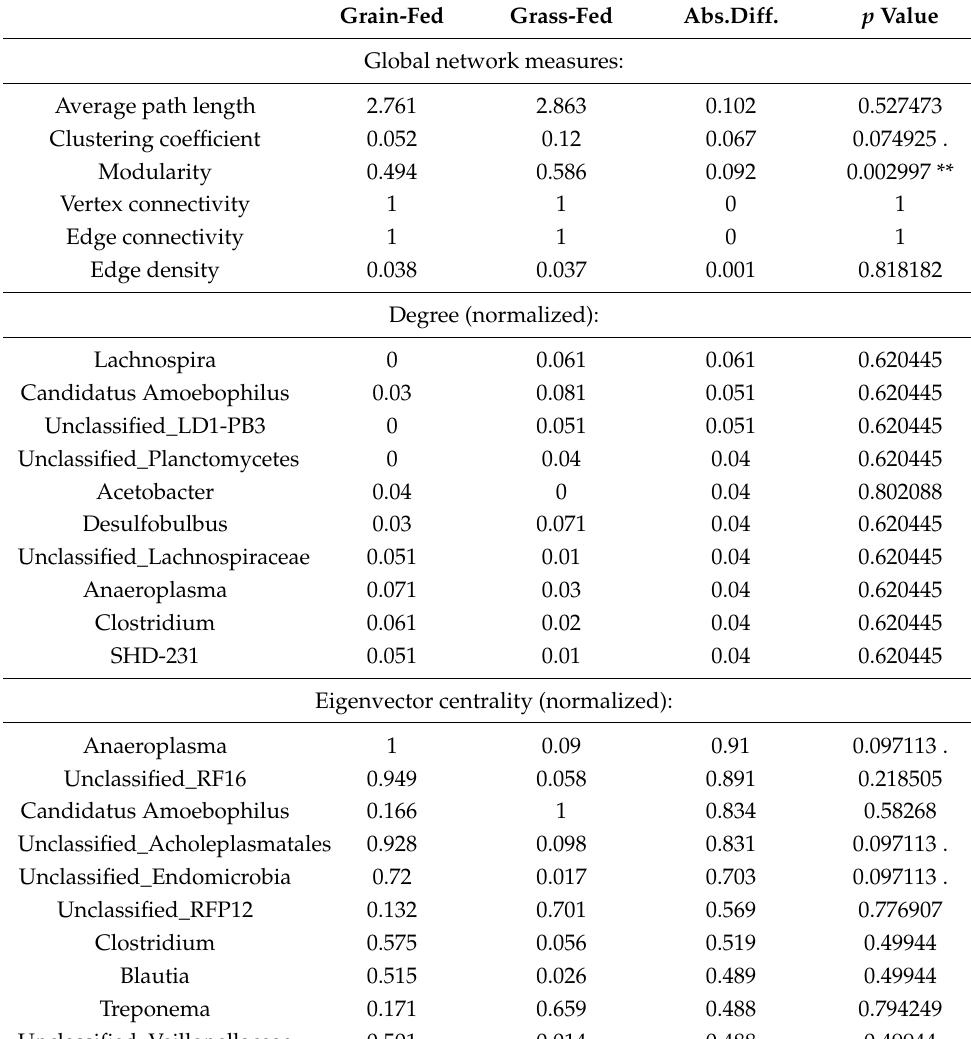
Table 2. Global network metrics and centrality measures of the grain-fed and grass-fed networks. The abs.diff. denotes the absolute difference between the measures of the two groups. p Values were adjusted for multiple testing with an adaptive Benjamini–Hochberg